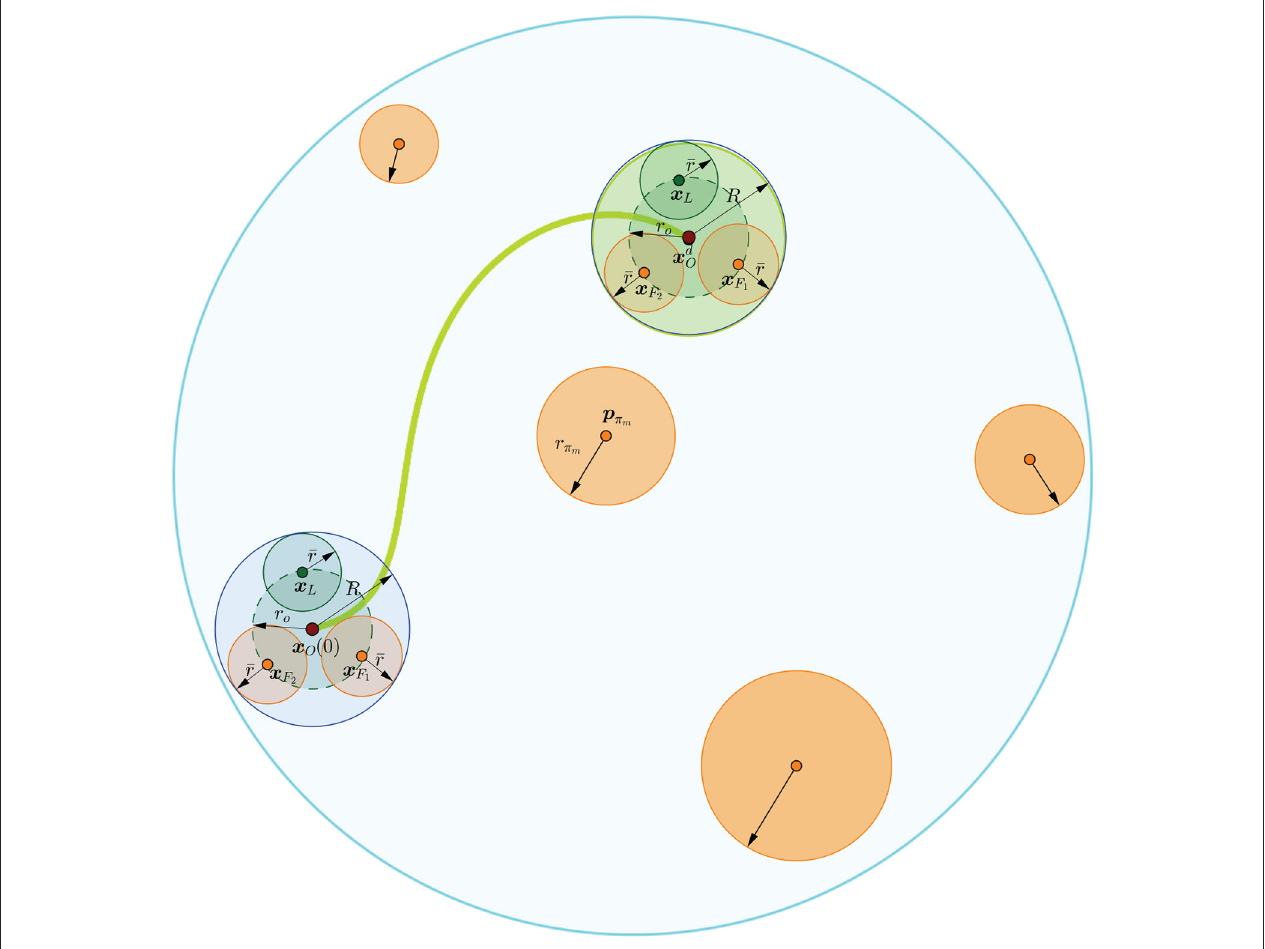
FIGURE 3 | Graphical representation of a safe trajectory of the robotic team. The orange areas indicate the obstacles and the cyan line the workspace boundary. The blue line encircles the area covered by the robotic team and the object.